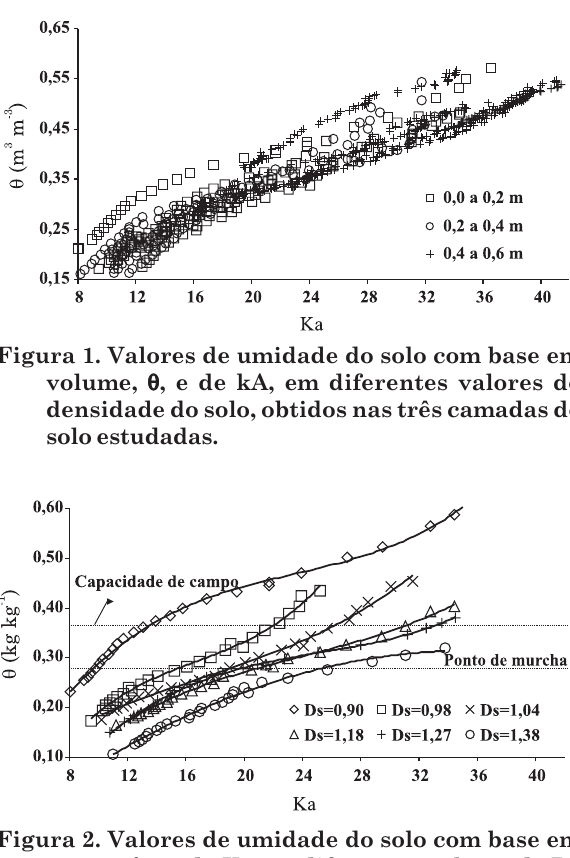
Figura 2. Valores de umidade do solo com base em massa, θθθθθ g, e de Ka em diferentes valores de Ds (Mg m -3 ), obtidos nas três camadas de solo